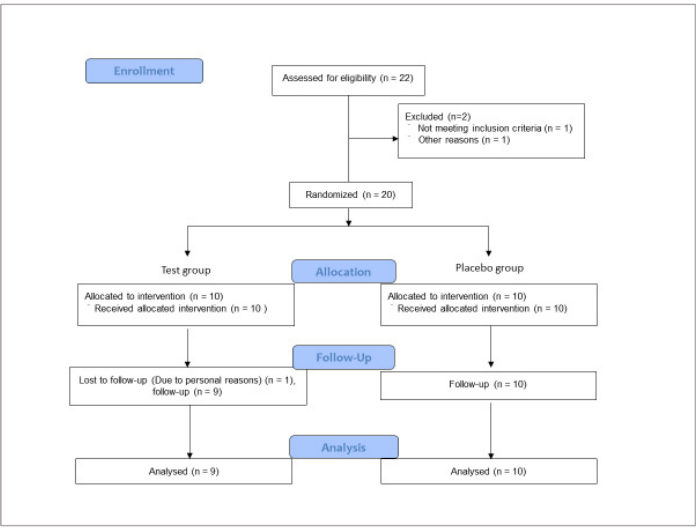
Figure 1. The study flow diagram. Table 2. Background characteristics of the participants.